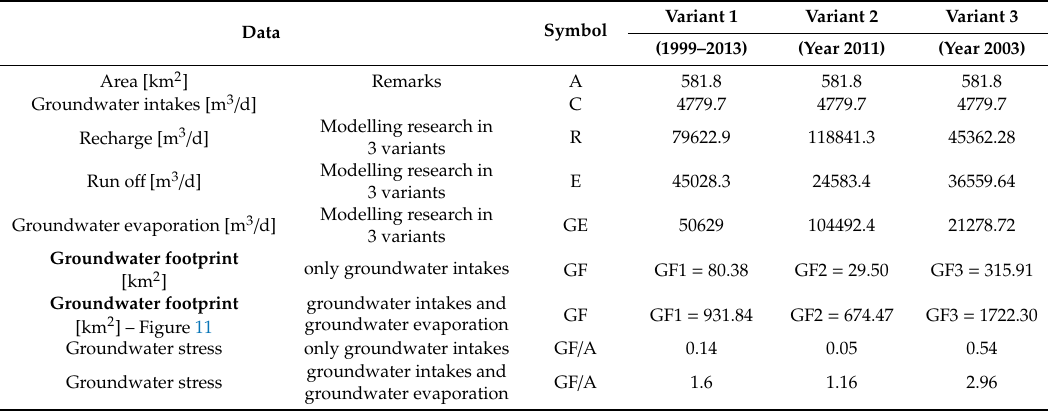
Table 5. Groundwater footprint, groundwater stress in variant 1–3.